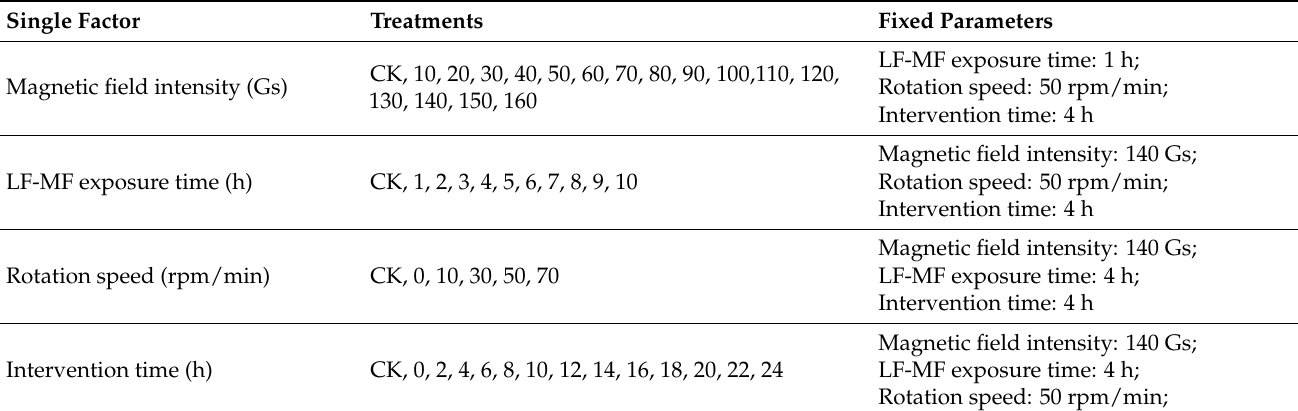
Table 1. The magnetic field treatment single factor optimization strategy. Single Factor Treatments Fixed